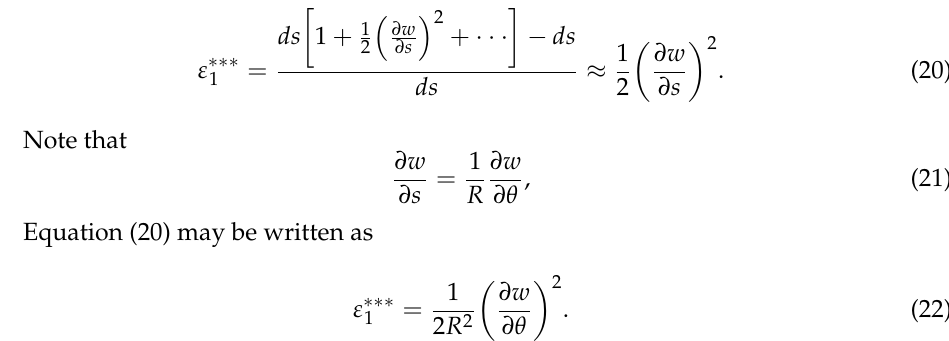
Figure 5. The strain ε 1*** due to slope change in the segment along the θ direction introduced by w. Spreading the expression in the square root by Taylor series, that is,